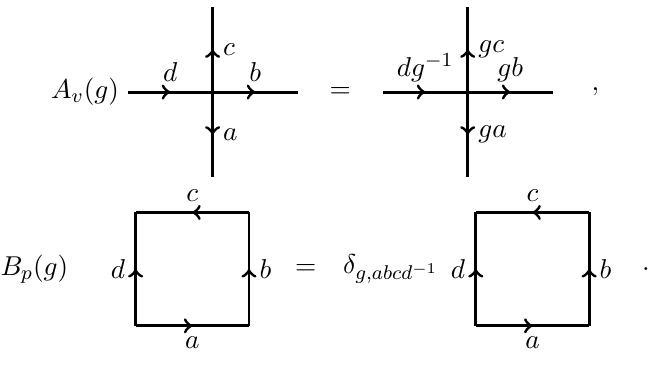
Figure 1 . An illustration of the action of A v ( g ) and B p ( g